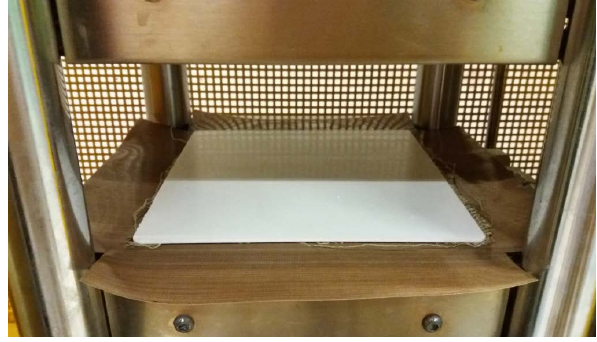
Figure 2: Banana nonwoven.